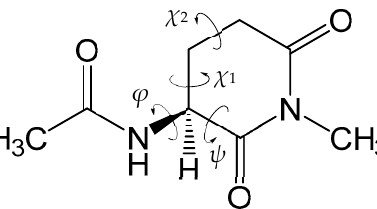
Figure 1. Chemical structure of the model compound (Ace ‒ L -GI ‒ Me) used in this study. The dihedral angles φ (C ‒ N ‒ C α ‒ C) and ψ (N ‒ C α ‒ C ‒ N), which characterize the main-chain conformation, and the dihedral angles χ 1 (N ‒ C α ‒ C β ‒ C γ ) and χ 2 (C α ‒ C β ‒ C γ ‒ C δ ), which characterize the side-chain conformation, are indicated.